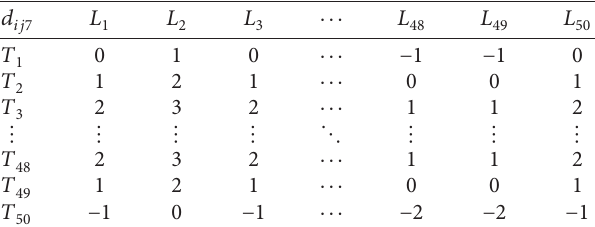
Table 25: Profit and loss matrix D housing online ratings.